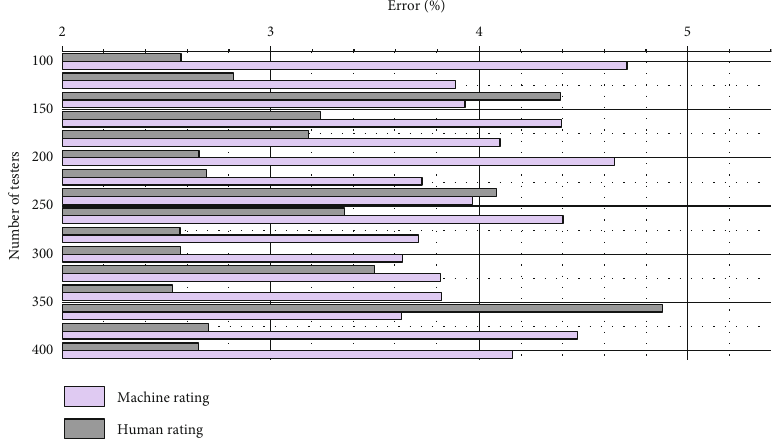
Figure 5: Error between human rating and machine rating. Table 2: Number of paired samples for human-machine rating.